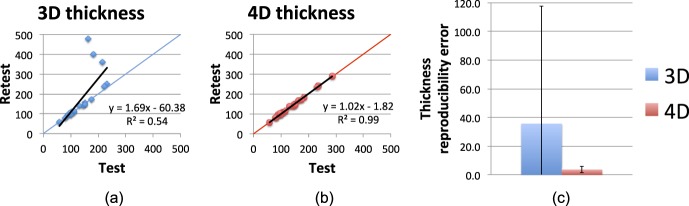
Choroidal thickness reproducibility in the glaucoma cohort. All units are micrometer. (a) Test–retest choroid thickness measurements (μm) for cross-sectional (3D) segmentation. The regression line is shown in black, and the y = x line is shown in color for reference. (b) Test–retest choroid thickness measurements (μm) for longitudinal (4D) segmentation. The regression line is shown in black, and the y = x line is shown in color for reference. (c) Thickness reproducibility error for the two methods. Mean and SD of absolute reproducibility error are shown for each method.